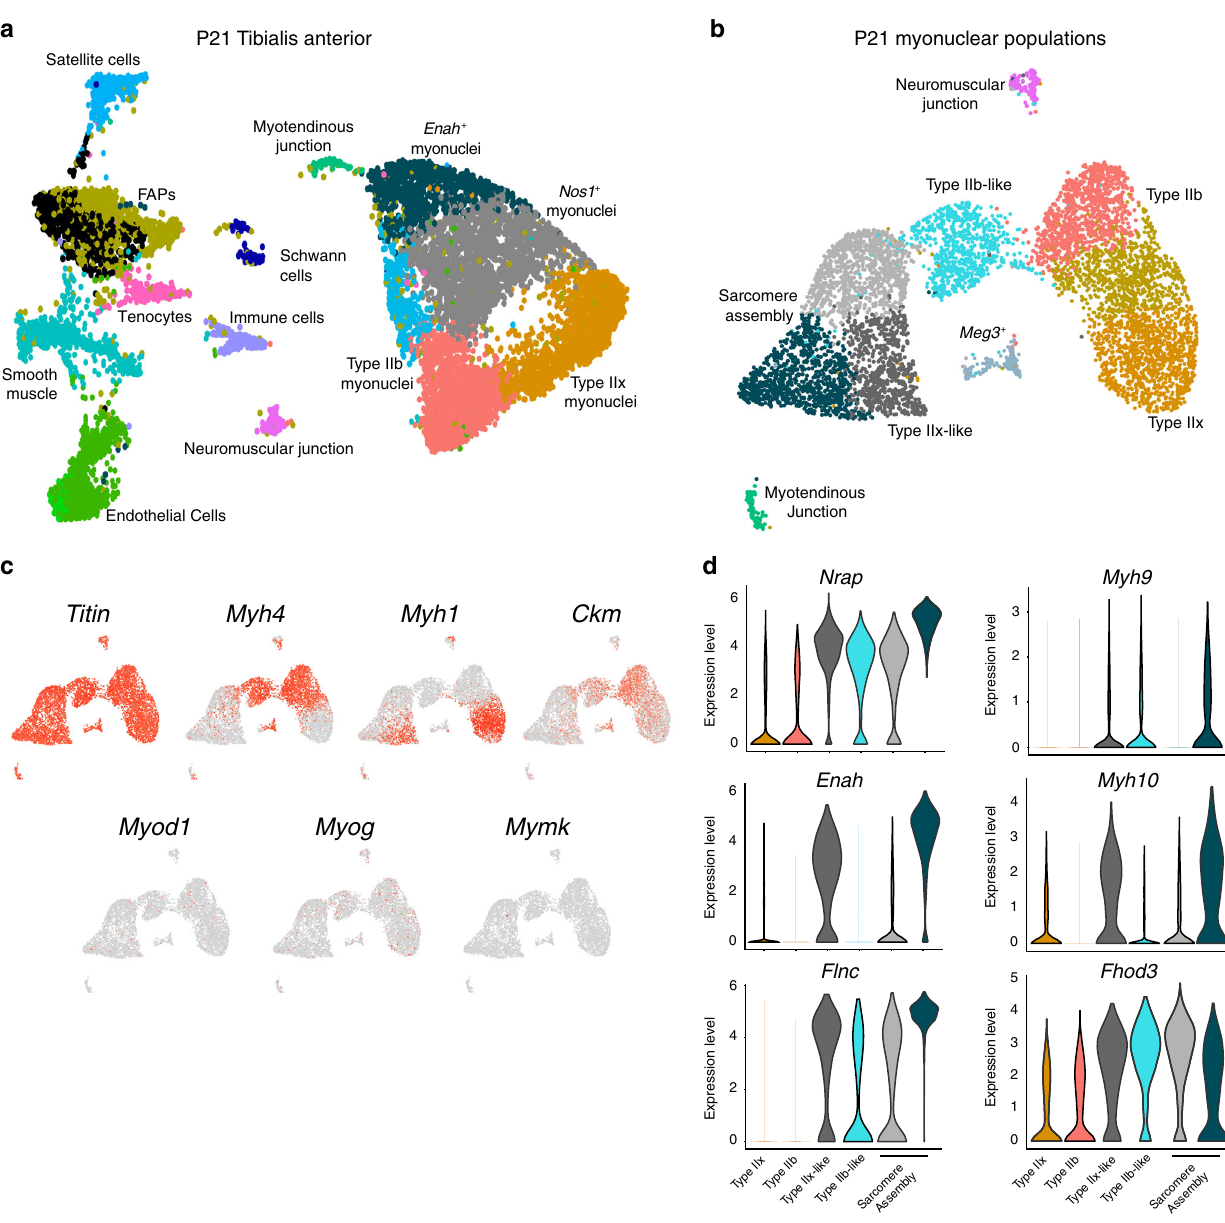
Fig. 2 Temporal myonuclear heterogeneity revealed in developing muscle. a Unbiased clustering of nuclei from postnatal (P) day 21 presented in a UMAP revealed all major populations in addition to unique myonuclei outside the canonical Type IIb and Type IIx myonuclei. These nuclei populations were marked by Nos1 and Enah, respectively. b Subclustering of myonuclear populations from P21 muscle revealed sarcomere assembly myonuclear states. c Feature plots assessing expression of mature muscle markers ( Ttn , Myh1 , Myh4 , and Ckm ) and differentiation markers ( Myod1 , Myog , Mymk ) from the myonuclear populations in b . d Violin plots showing the sarcomere assembly myonuclei are enriched for a transcriptional pro fi le associated with early myo fi brillogenesis (expression of Nrap , Enah , Flnc , Myh9 , Myh10, Fhod3